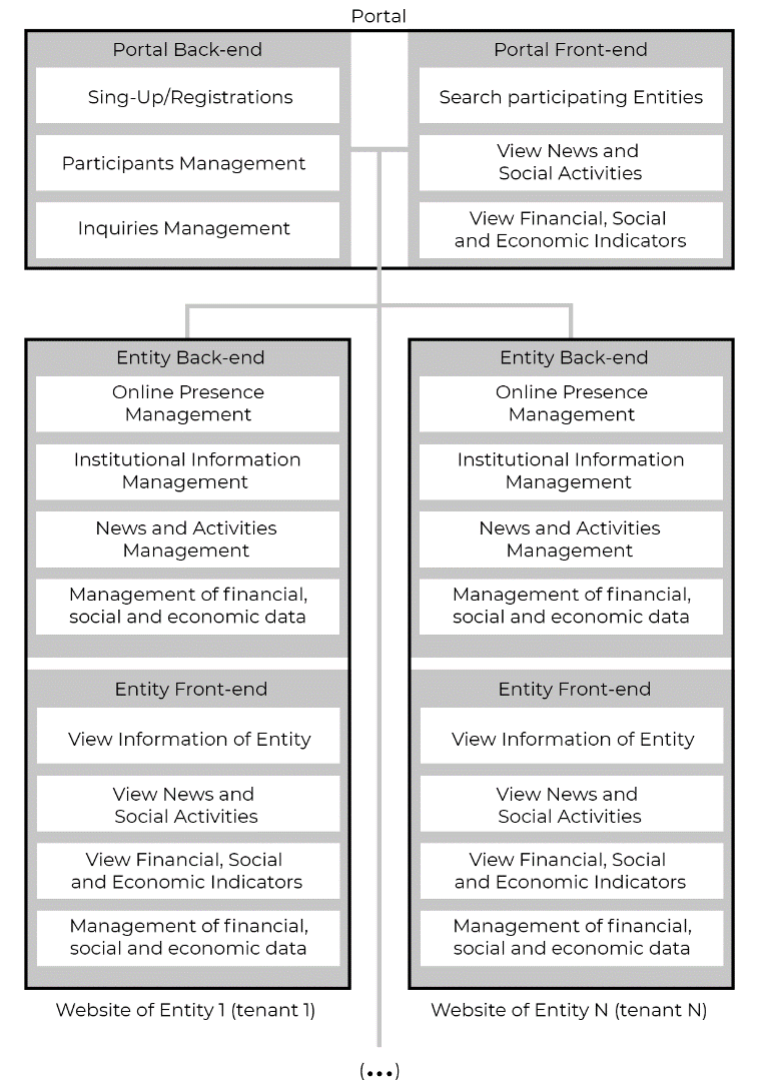
Figure 2. Block diagram of the platform (Marques, Santos and Duarte,